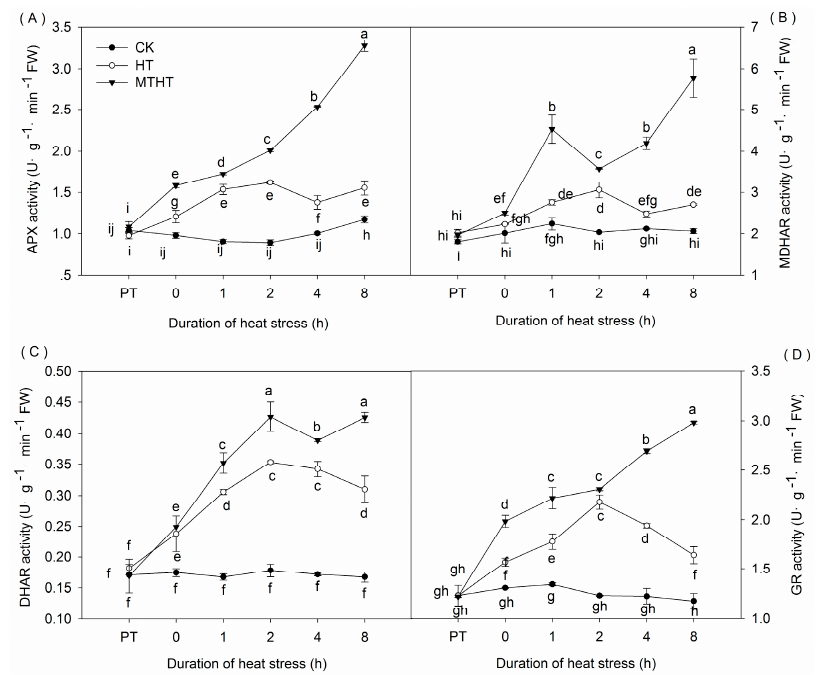
Figure 4. Activity of key enzymes from the AsA-GSH cycle in heat-stressed kiwi leaves. ( A ) Ascorbate peroxidase (APX); ( B ) monodehydroascorbate reductase (MDHAR); ( C ) dehydroascorbate (DHAR); and ( D ) glutathione reductase (GR). Lowercase letters indicate significant differences ( p < 0.05).